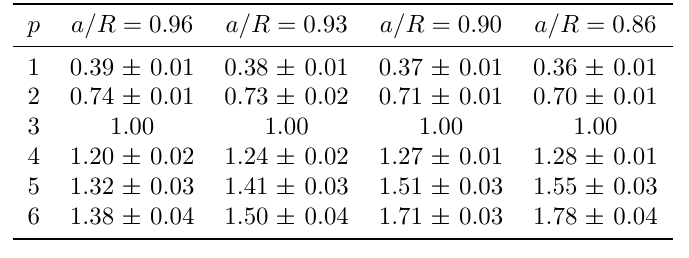
Table 2: Normalized scaling exponents 𝜉 𝑝 /𝜉 3 for radial magnetic fluctuations in a laboratory plasma, as measured at different distances 𝑎/𝑅 ( 𝑅 ≃ 0 . 45 cm being the minor radius of the torus in the experiment) from the external wall. Errors represent the standard deviations of the linear fitting. Scaling exponents have been obtained using the